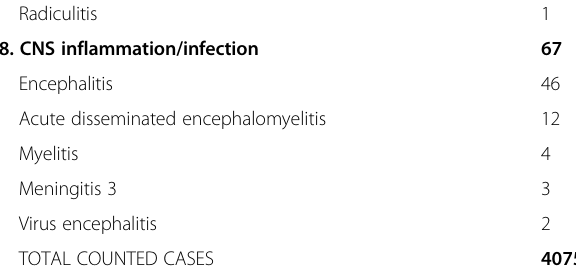
Table 1 Overview of neurologic manifestations in